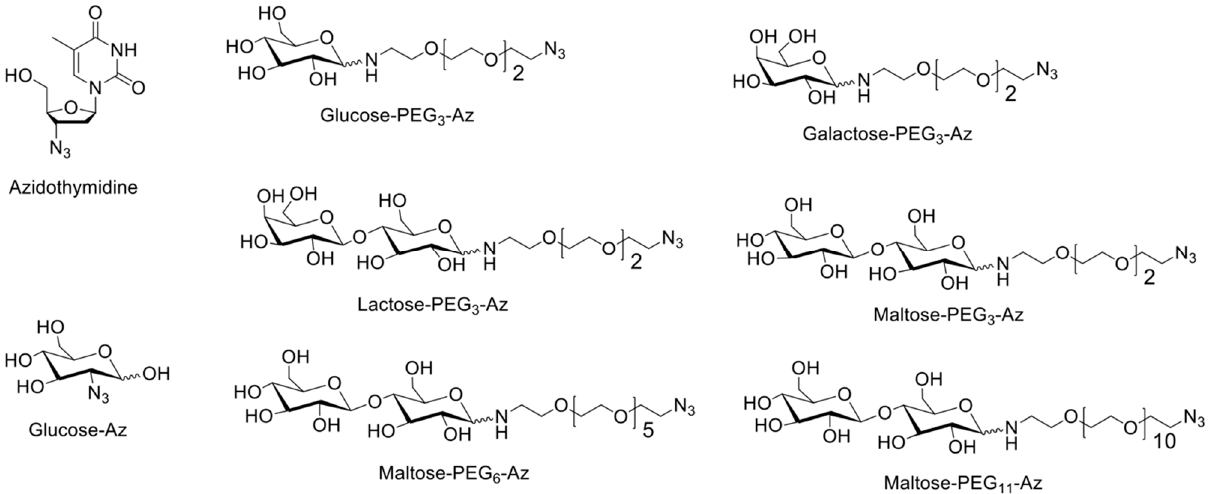
Figure 3. The reaction between DPTA and maltose-PEG 3 -azide leading to the generation of phos- phine oxide (7) and the elimination of (8) ( A ). 1 H-NMR spectroscopic kinetic analysis of the reaction between DPTA and maltose-PEG 3 -azide ( B ). Marks “a”, “b”, and “c” in Figure 3B are the protons described in Figure 3A. The reaction between DPTA ( 4 ) and the sugar azide generates intermediate ( 7 ), where sugar gets attached to DPTA via an amide bond and the phosphine group is converted to